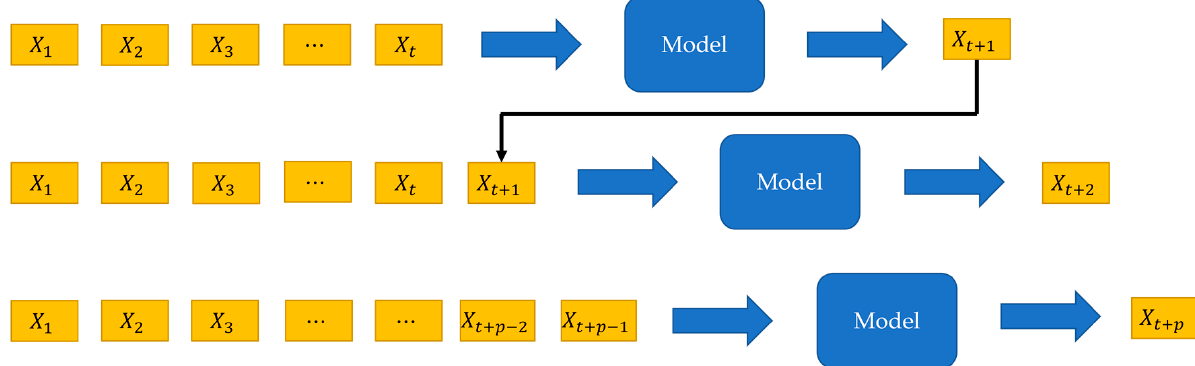
Figure 6. Recursive forecast strategy.